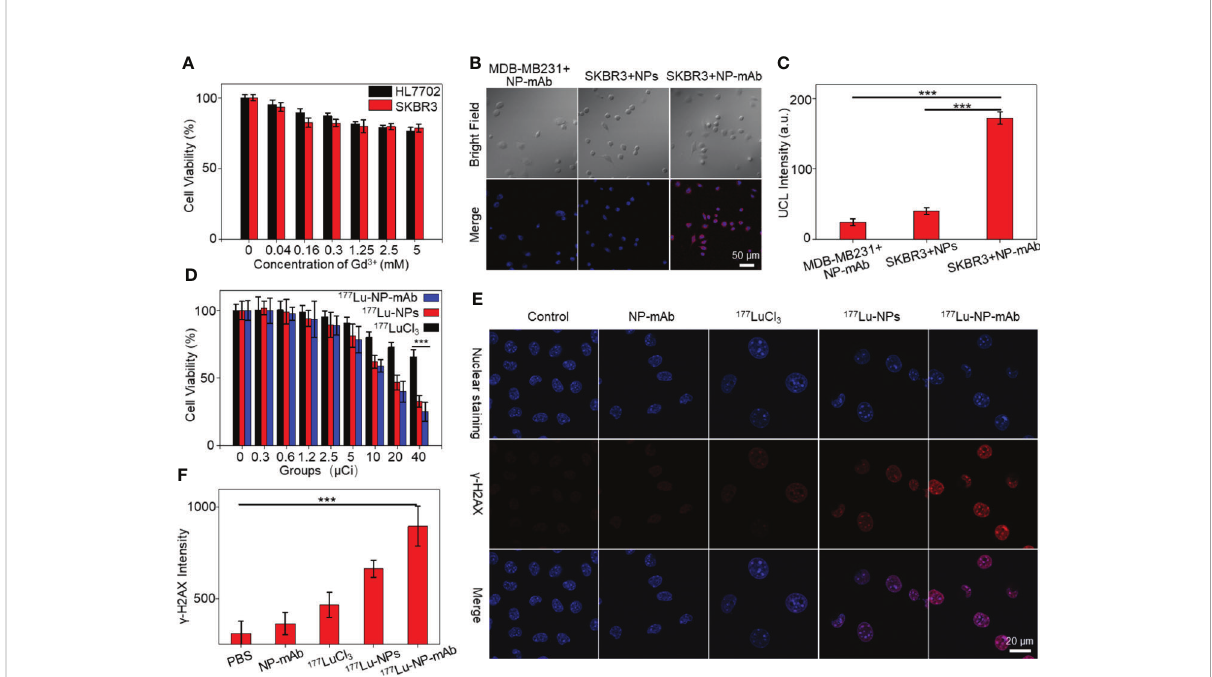
FIGURE 2 Cell experiments. (A) The cytotoxicity of NP-mAb at different concentrations. (B) Confocal imaging of the HER2 over-expressed cell line (SKBR3) and HER2 low-expressed cell line (MDA-MB-231) incubated with the NPs and NP-mAb, respectively (blue: Nuclear staining, red: UCL Channel, the embedded scale bars correspond to 50 m m). (C) UCL Intensity of confocal imaging in cell binding experiment (***P< 0.001). (D) Relative viabilities of SKBR3 cells treated with different doses of free 177 Lu, 177 Lu-NPs and 177 Lu-NP-mAb for 24 h. Asterisks indicate statistical signi fi cance (***P< 0.001). (E) g -H2AX fl uorescence images (blue: Nuclear staining, red: g -H2AX) of SKBR3 cells with different treatments. (F) g -H2AX Intensity of confocal imaging in DNA damage (***P<